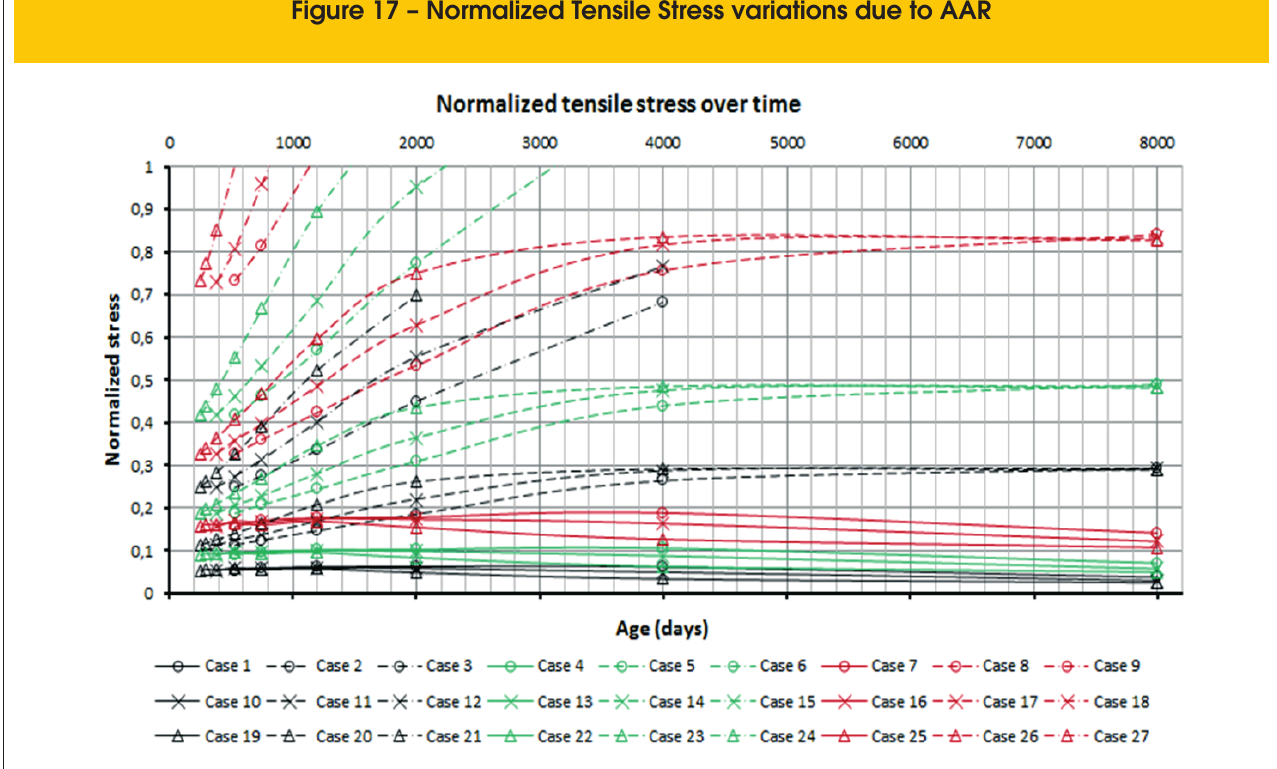
Figure 17 – Normalized Tensile Stress variations due to